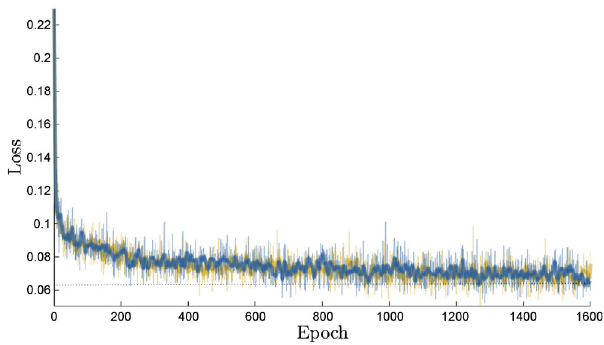
Fig. 3 Network loss convergence. The graph demonstrates the losses on the training (yellow) and test (blue) data. The loss function is not completely stable due to the presence of outlier swatches. Nonetheless, learning converges for both sets (starting from a loss of around 0 . 22, down to 0 . 07), demonstrating the network’s resiliency to